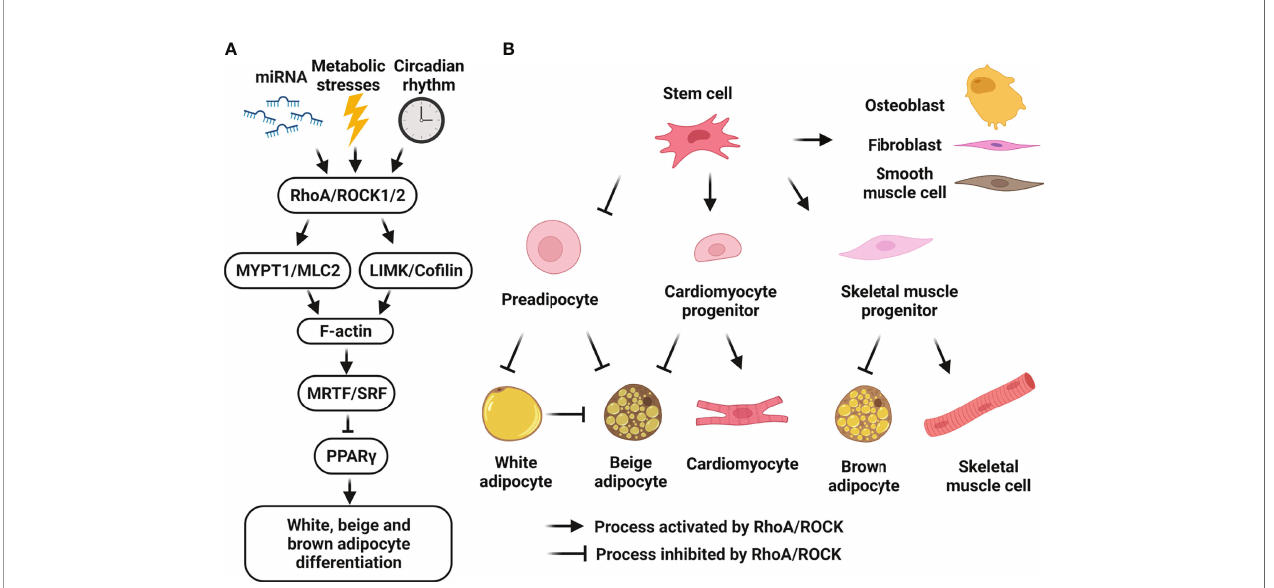
FIGURE 2 | Cellular roles of RhoA/ROCK signaling in white, beige and brown adipocyte differentiation. (A) Schematic representation of RhoA/ROCK pathway which negatively regulates adipocyte differentiation. RhoA/ROCK signaling-cascade activation can be induced by many risk-factors including mechanical stress, mitochondrial dysfunction, in fl ammation, ROS, aging, hyperglycemia and dyslipidemia, etc. Activated pathway causes actin polymerization and formation of stress fi bers, leading to nuclear translocation of MRTF and suppression of PPAR g activity. (B) Schematic representation of the regulation of cell fate determination of mesenchymal stem cells by RhoA/ROCK pathway. Activation of RhoA/ROCK signaling by local mechanical stresses and environment factors promotes the commitment to osteogenic versus adipogenic lineages of bone marrow mesenchymal stem cells and adipose tissue-derived stem cells. RhoA/ROCK activation also promotes the commitment to smooth muscle cell-like and fi brogenic lineages versus adipogenic lineage of perivascular progenitors. Moreover, RhoA/ROCK activation favors a switch toward myogenesis versus brown adipogenesis of common mesenchymal precursors, and a switch toward cardiomyocytes versus beige adipocytes of embryonic cardiac progenitors. Finally, RhoA/ROCK activation negatively regulates preadipocyte differentiation towards white and beige adipocytes, and transdifferentiation of white adipocytes to beige adipocytes. (Figure is created with BioRender.com).